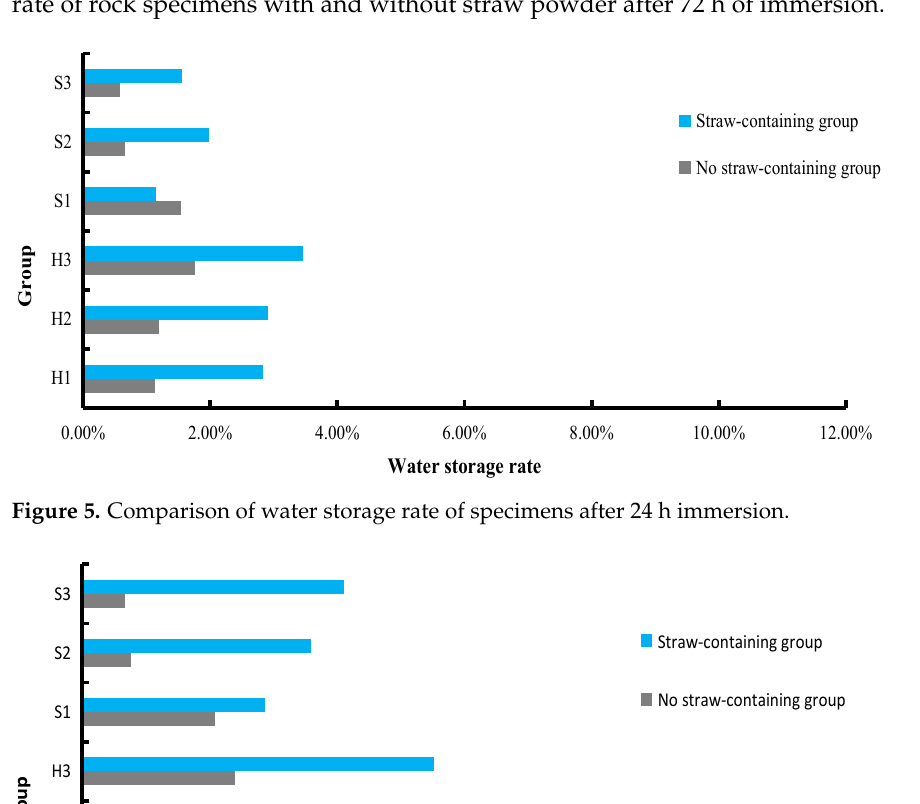
Figure 4. Total curves of water storage rate of rock specimens in 72 h.